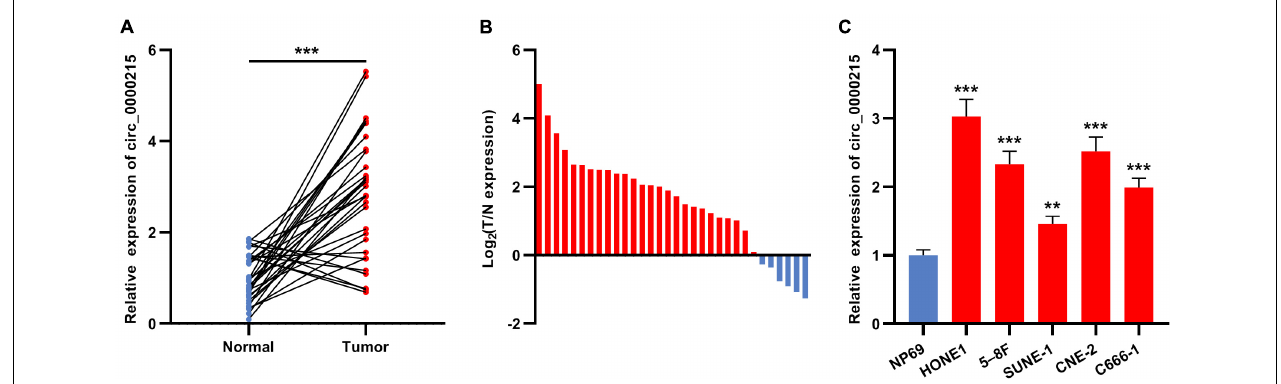
FIGURE 1 | Circ_0000215 expression is up-modulated in NPC. (A) qRT-PCR was performed to detect circ_0000215 expression in 32 pairs of NPC tissues and normal tissues adjacent to cancer. (B) Circ_0000215 expression was up-modulated in 81.25% (26/32) of the 32 NPC tissues. (C) Circ_0000215 expression in NPC cell lines (HONE1, 5-8F, SUNE-1, CNE-2, and C666-1) and immortalized normal nasopharyngeal epithelial cell line NP69 cells was examined by qRT-PCR. The significance of difference was determined by Student’s t -test or one-way ANOVA. ** P < 0.01, and *** P < 0.001. Data from three independent experiments were expressed as mean ± standard deviation.